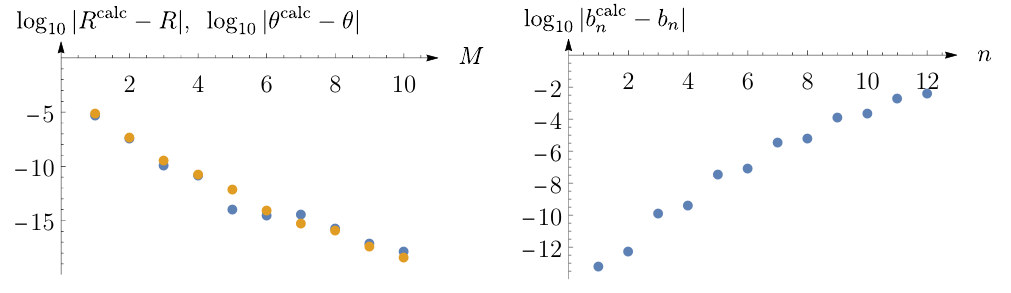
Figure 10. Plot of the errors of our results after the use of the Case 1b algorithms in eqs. (3.49) and (3.52). Left: error in the calculated values of R (in blue) and θ (in orange) versus M (for N 0 = 300 ). Right: error in the first 12 coefficients b n of the expansion of w 1 ( z ) around z = z 1